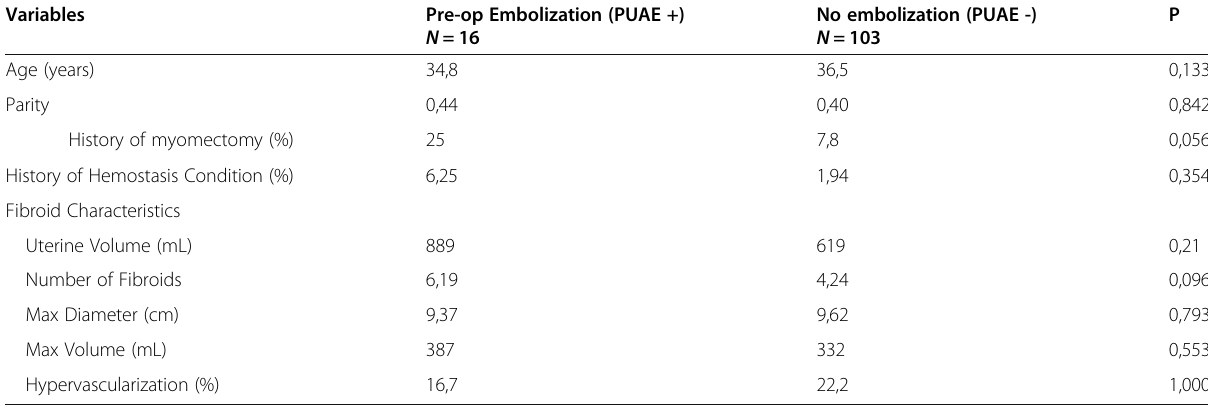
Table 1 Patients Characteristics Variables